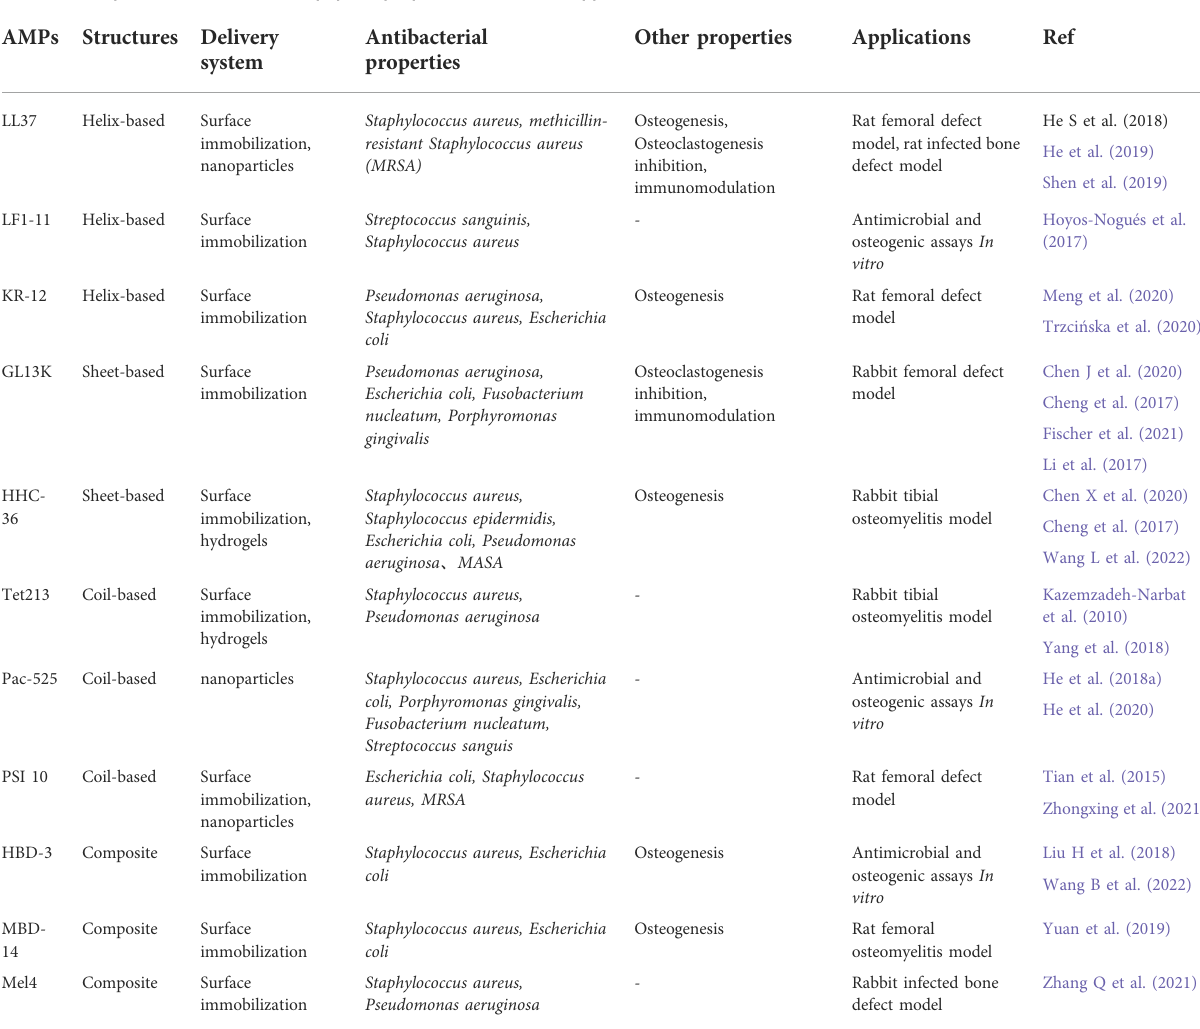
TABLE 1 Comparison of antimicrobial peptide properties and related